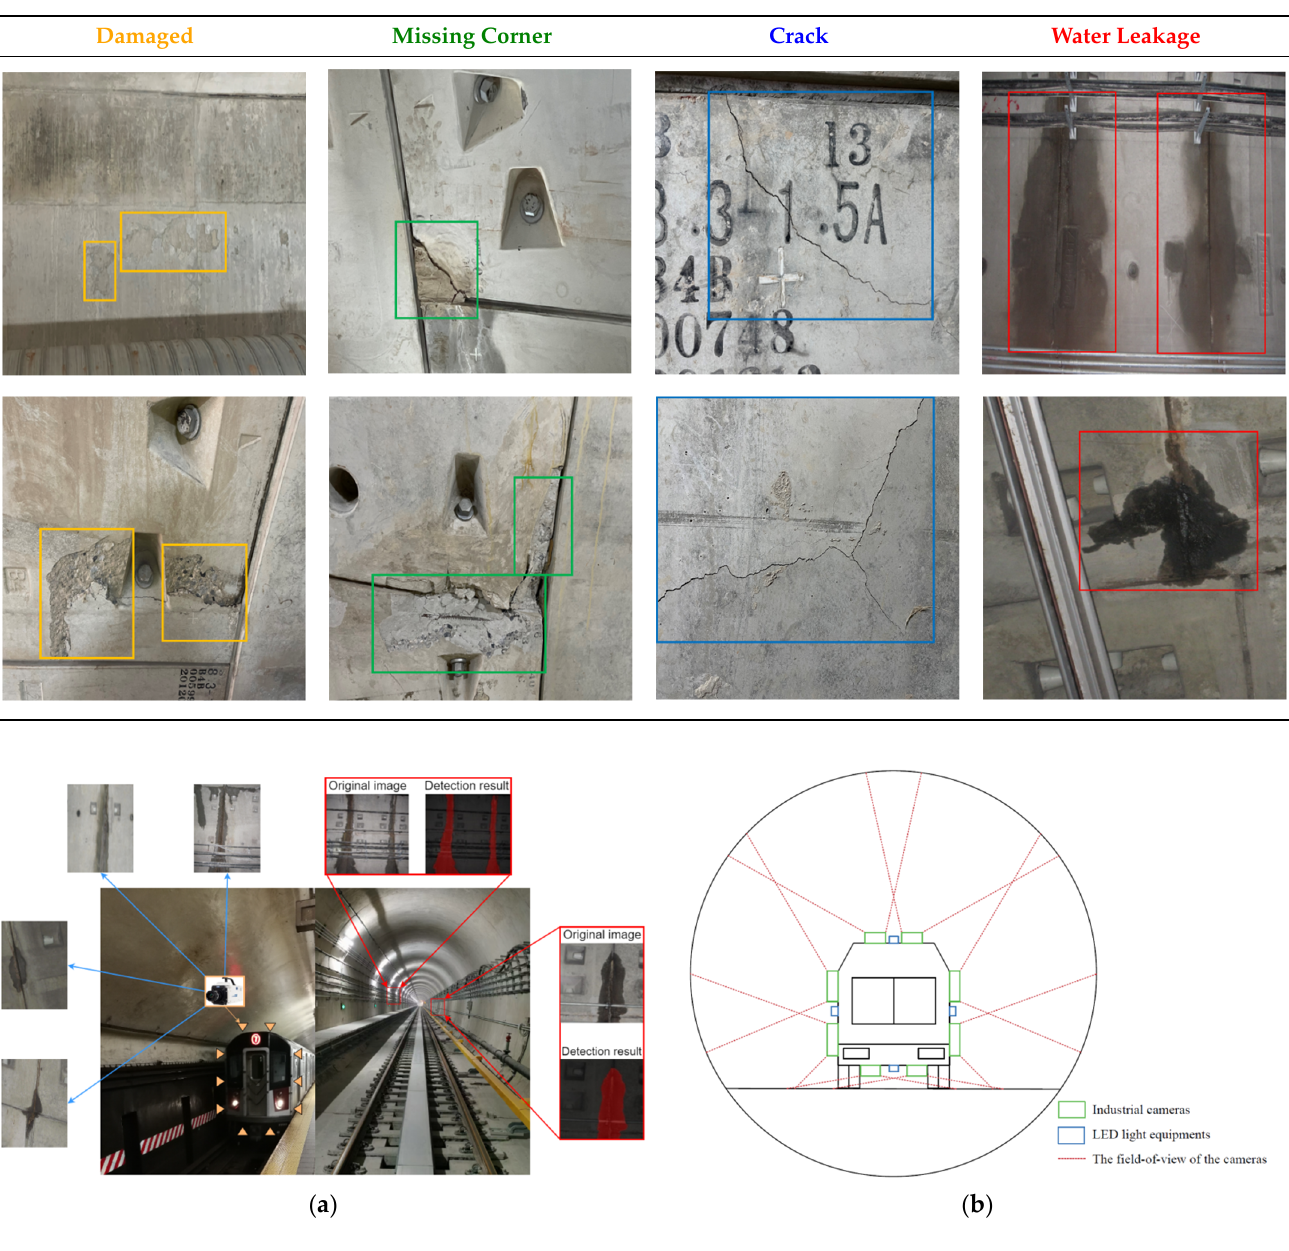
Figure 1. The Mobile Vision Measurement System. ( a ) The real-time detection, ( b ) The schematic diagram of the system